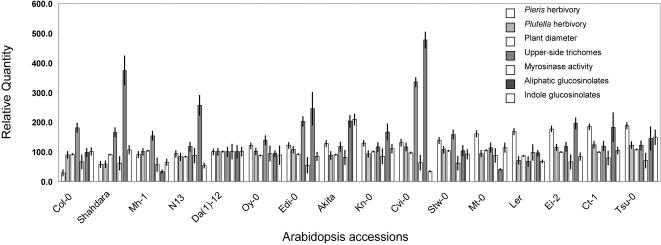
Natural variation among 16 Arabidopsis accessions for insect resistance, growth and defense-related traits.Accessions are ranked according to increasing susceptibility to herbivory by Pieris brassicae larvae. Shown are least squares means and standard errors (vertical bars) for Pieris brassicae herbivory, Plutella xylostella herbivory, plant diameter, leaf upper-side trichomes, myrosinase activity, aliphatic and indole glucosinolates. Values for Da(1)-12 are set as 100.